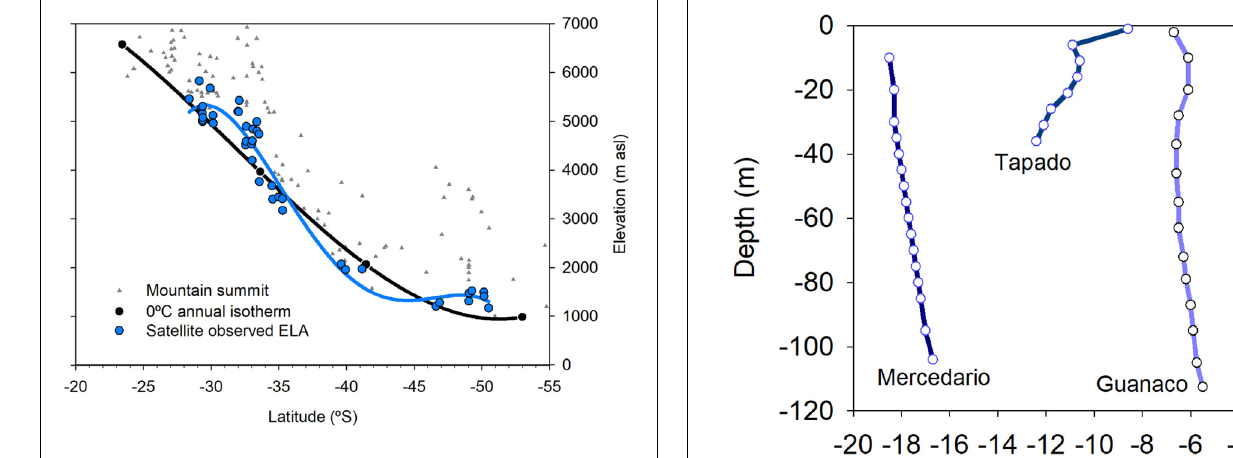
FIGURE 4 | Gradient along the southern Andes of the 0 ◦ C isotherm and the equilibrium-line altitude (ELA) of glaciers estimated from climatic variables. Individual summits are shown in triangles. Adapted from Carrasco et al. (2008).